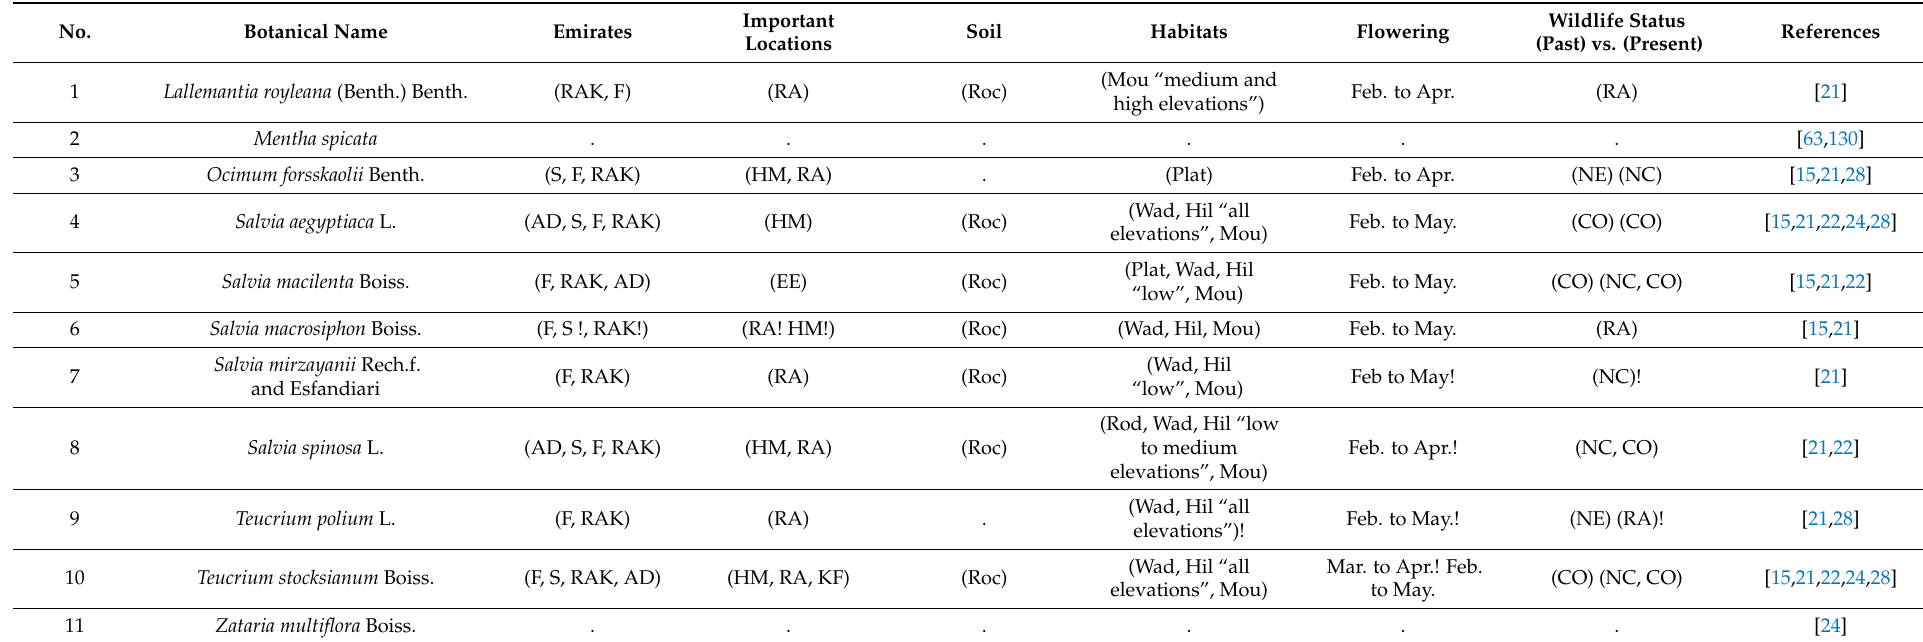
Table 7. Location of the UAE EO-bearing plants of Lamiaceae/Labiatae.